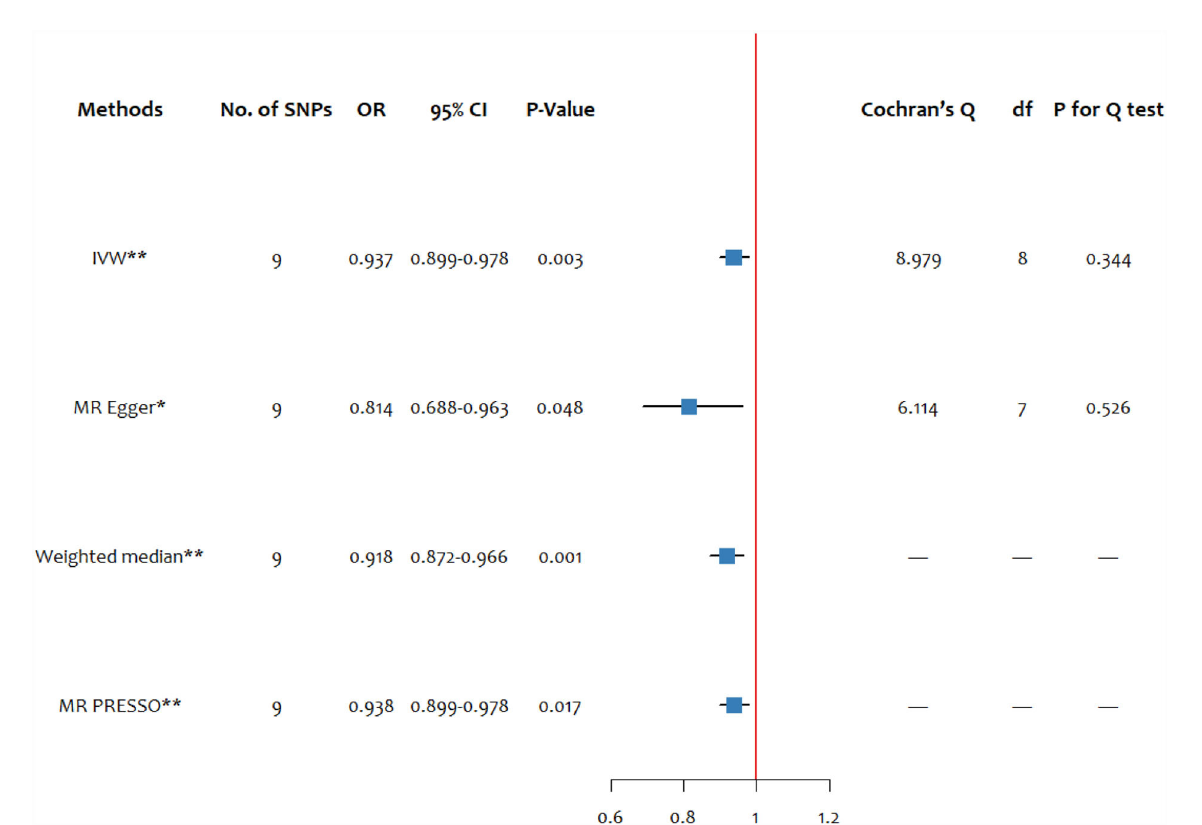
FIGURE3 The forest plot of MR estimates and the Cochran’s Q-test for blood and the toenail selenium level on schizophrenia. SNP, single-nucleotide polymorphism; df, degree of freedom; IVW, inverse variance weighted; MR-PRESSO, MR pleiotropy residual sum and outlier. * significant at p < 0.05, ** significant at p <